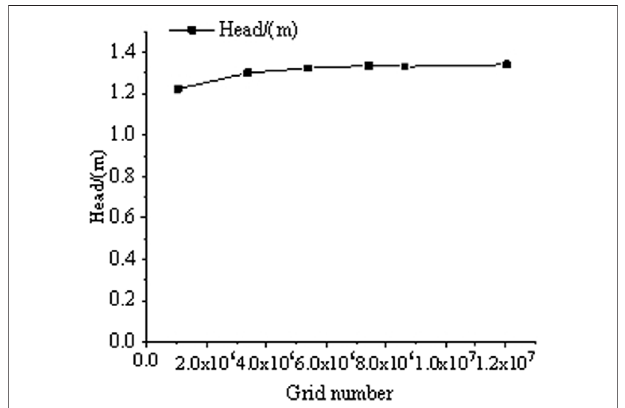
FIGURE 4 | Grid independence